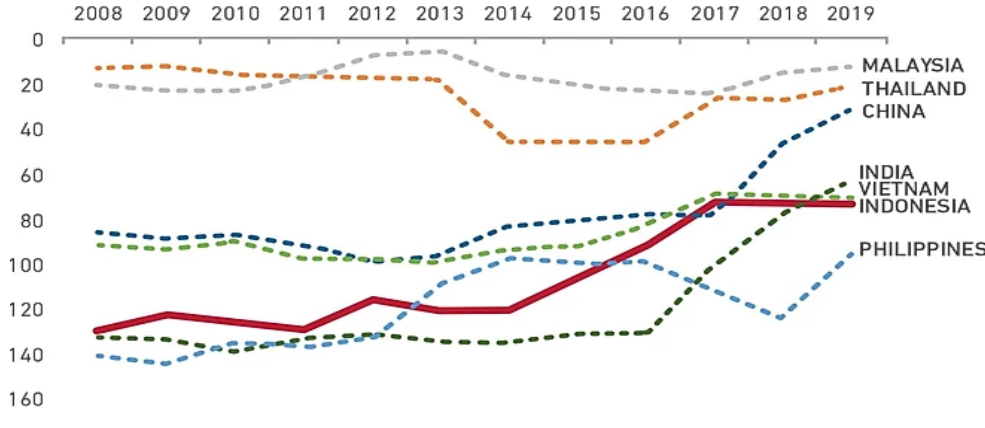
Figure 5: Ease of Doing